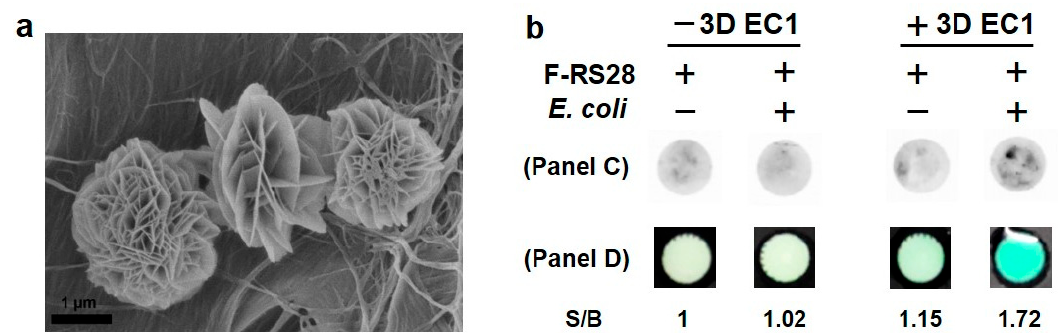
Figure 3. ( a ) SEM imaging of the printed 3D EC1. ( b ) Cleavage reaction with printed 3D EC1 on Panel C (top) and colorimetric reporting of the successful RCA reaction on Panel D (bottom). “ + ”: 10 7 E. coli cells added to a test sample. “ − ”: a test sample without E. coli cells. S / B: Signal-to-background ratio.